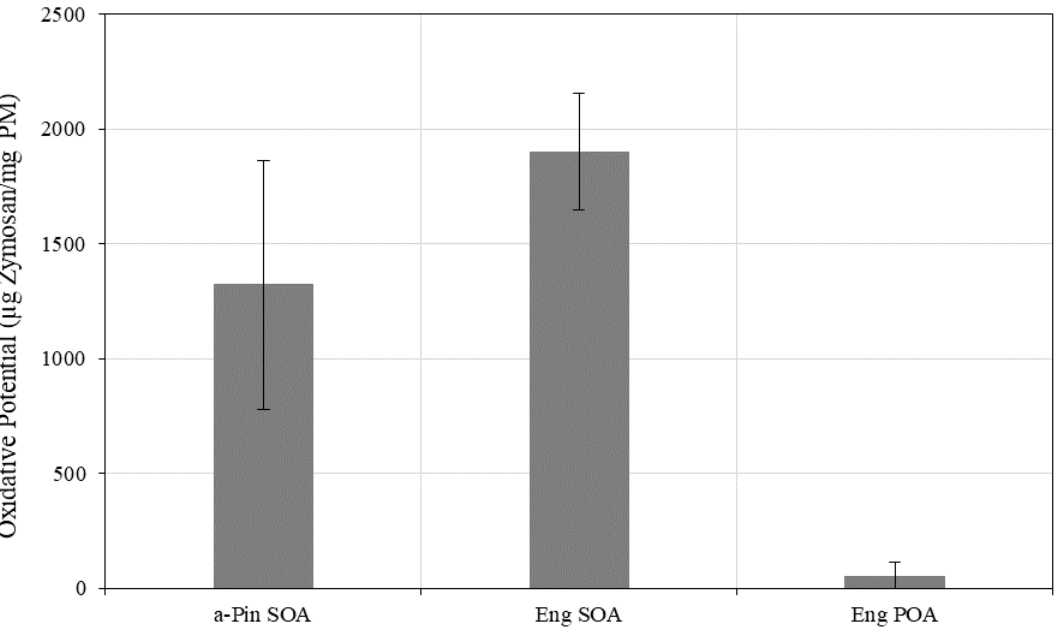
Dataset 1: Figure 3 EC-OC Raw Data 10.5256/f1000research.15445. d209280 (Lovett et al ., 2018a) Dataset 2: Figure 4 ROS Raw Data 10.5256/f1000research.15445. d209281 (Lovett et al .,